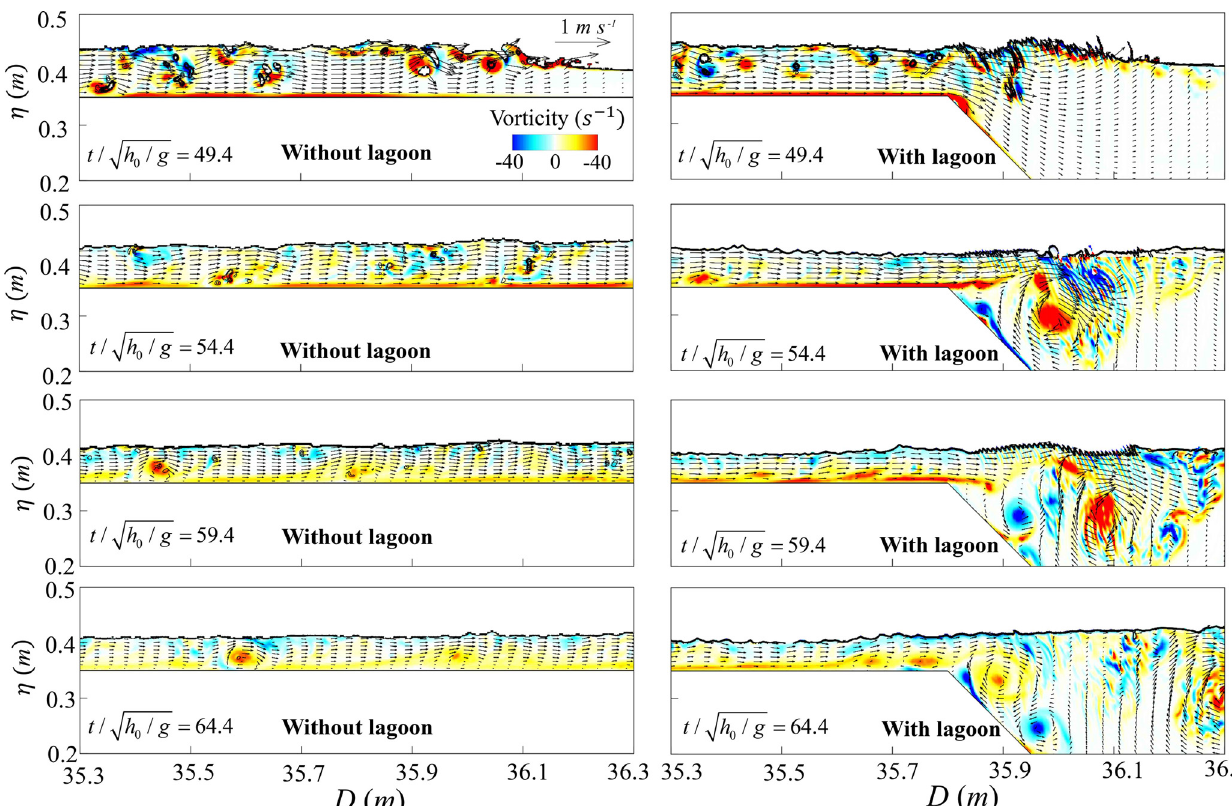
√ h 0 /g ) between the reefs with and